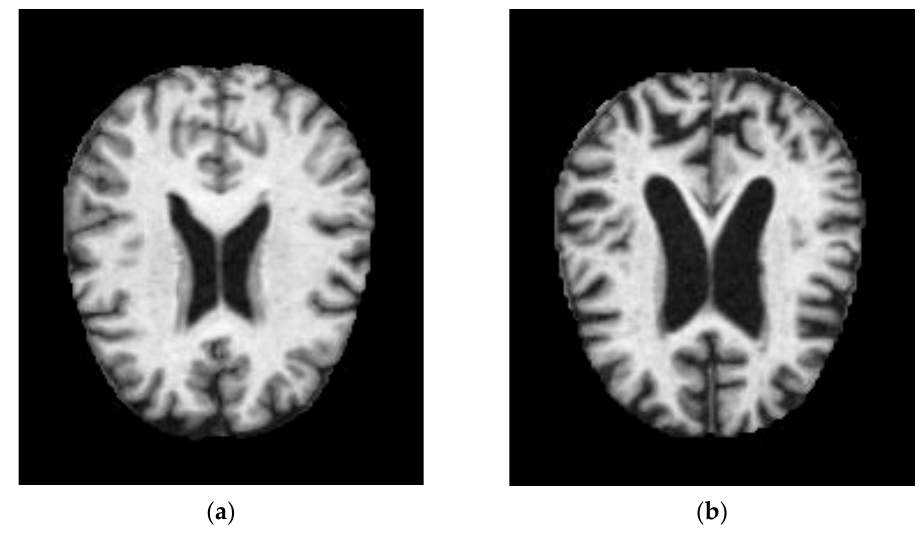
Figure 1. MRI images of ( a ) normal demented and ( b ) moderated demented